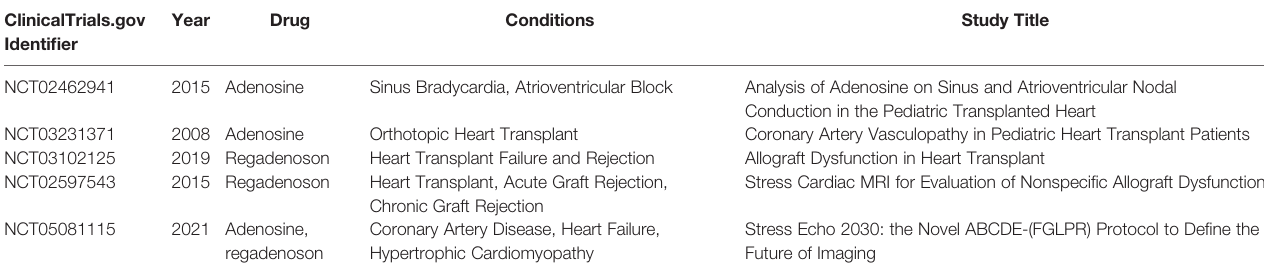
TABLE 1 | Clinical trials of purinergic signaling involved in heart transplantation. ClinicalTrials.gov Identi fi